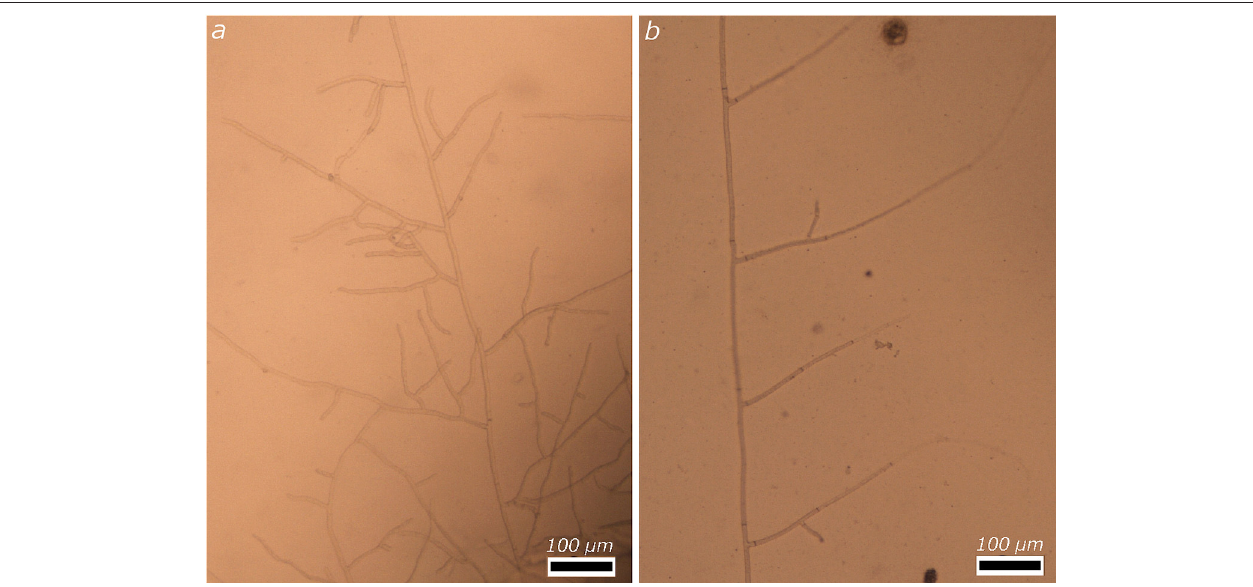
FIGURE 2 | Illustrative example of the growth of R. solani in the inlet section of the micromodel, (a) near the inoculation point, in the inlet well, and (b) hypha with 3 very regular segments, further toward the porous section of the micromodel.